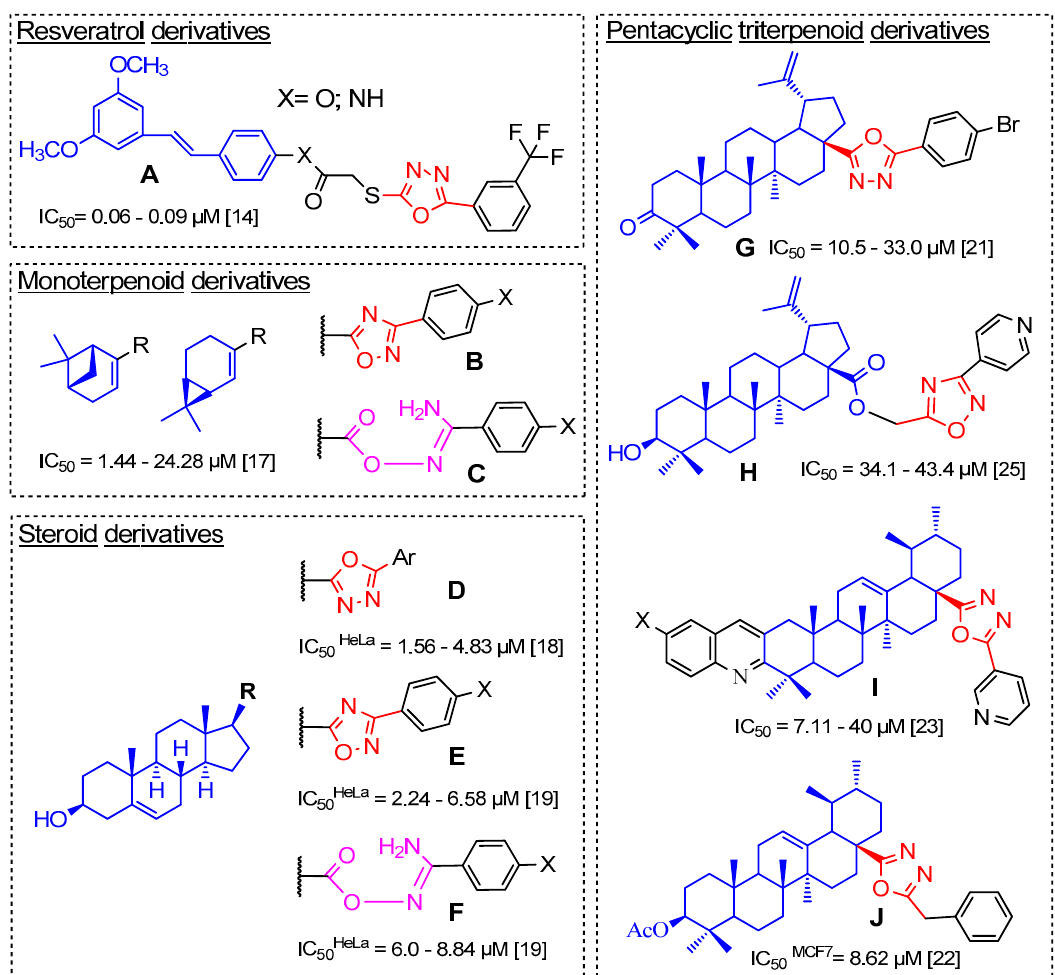
Figure 1 . Structures of semisynthetic derivatives of natural compounds bearing oxadiazole ( A,B,D,E , G–J) and amidoxime ( C , F ) moieties that display promising antitumor